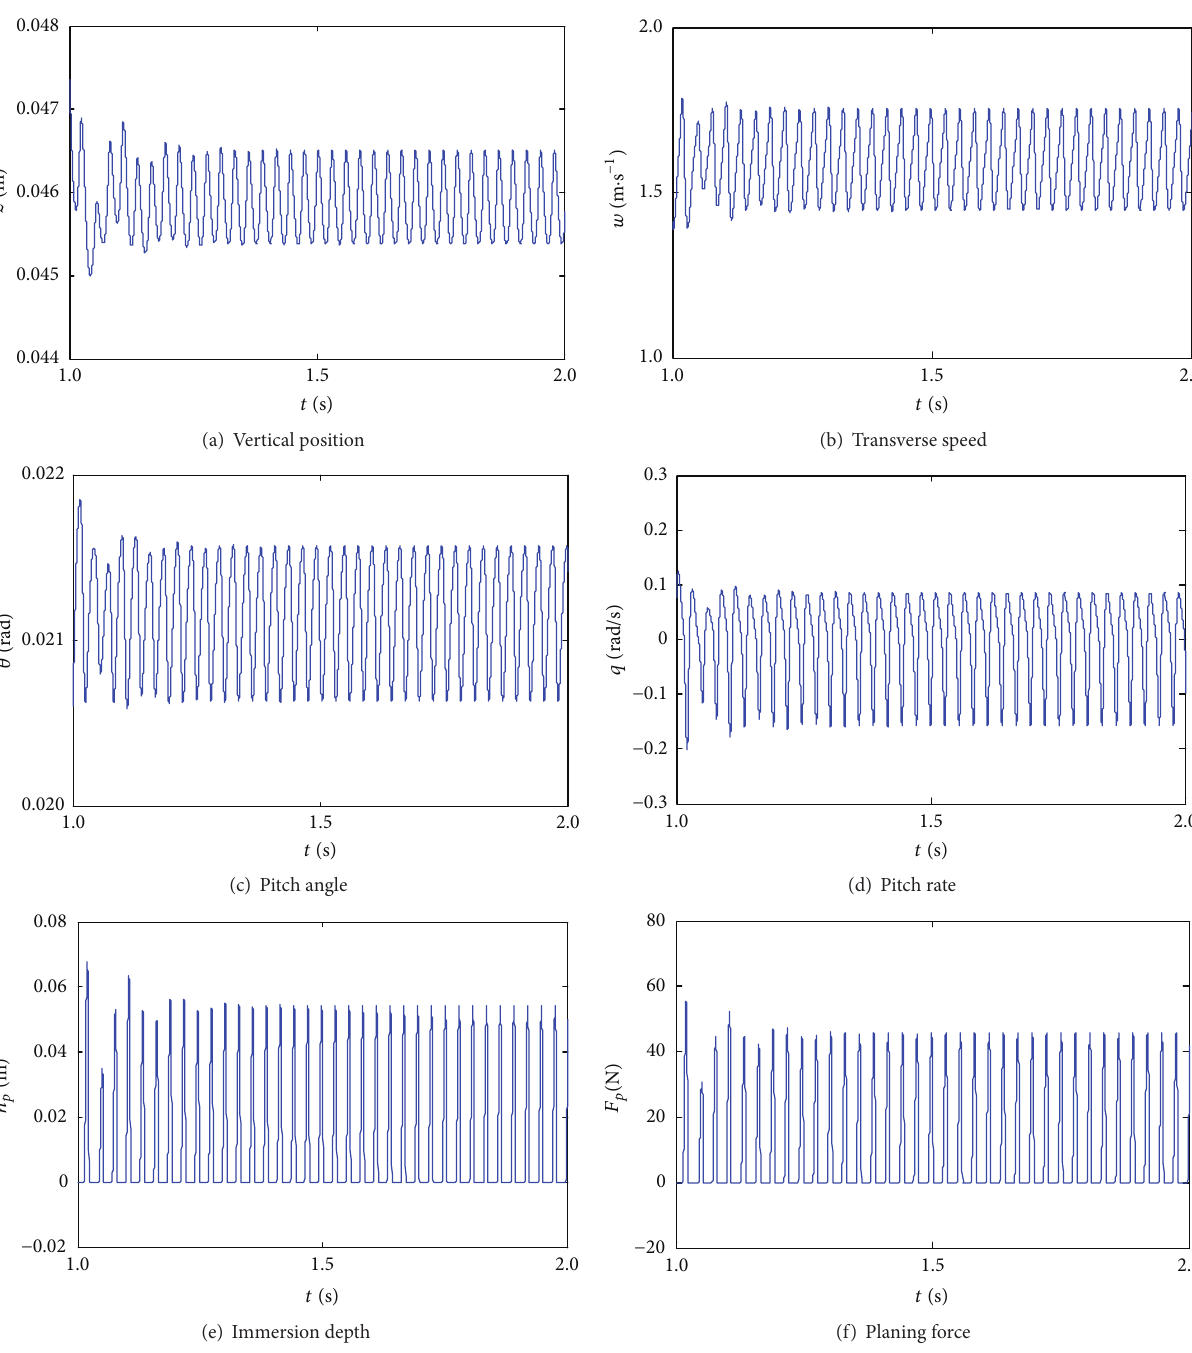
Figure 10: The motion state of the system when 𝑘 = 5